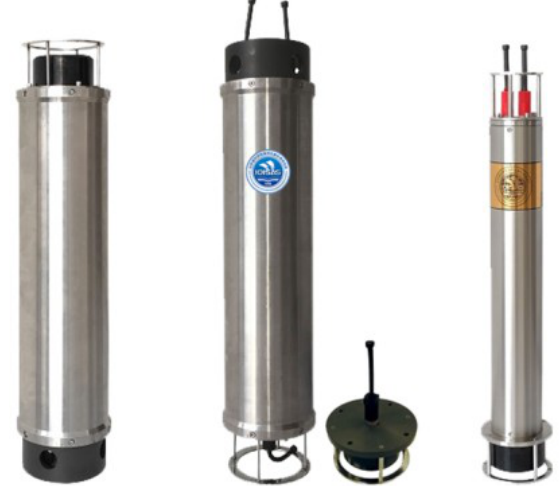
Figure 6. IOISAS